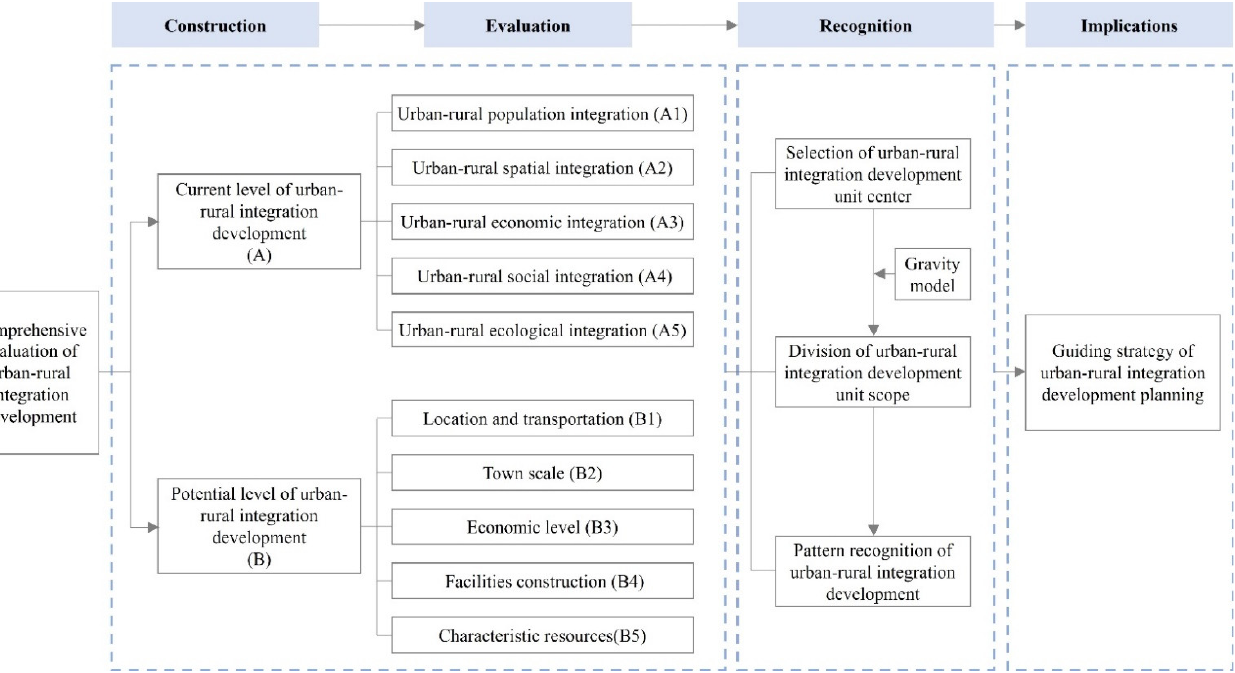
Figure 2. Research framework of this research.